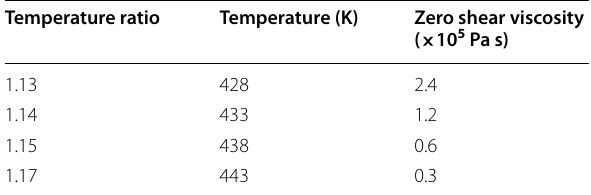
Table 4 Zero shear viscosity of PMMA at each